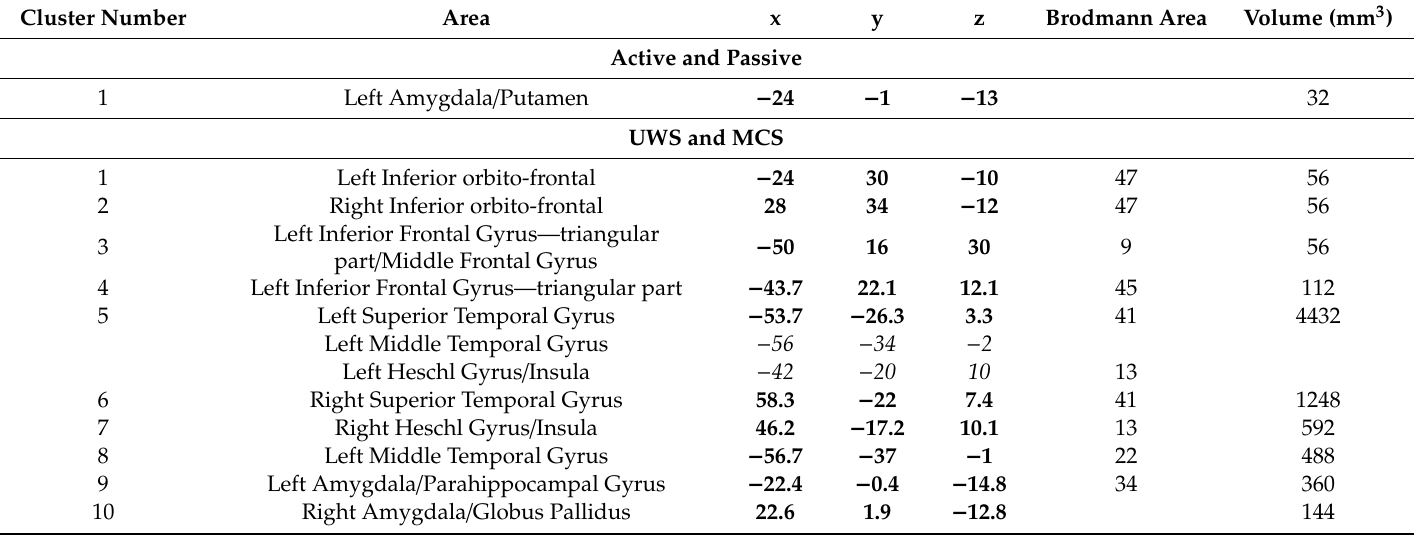
Table 5. Conjunction results. Brain areas of shared activation obtained by means of the contrast analysis procedure implemented in GingerALE [34–36] at p < 0.001 uncorrected (the FWE-corrected results are reported in Table S1 of the supplementary